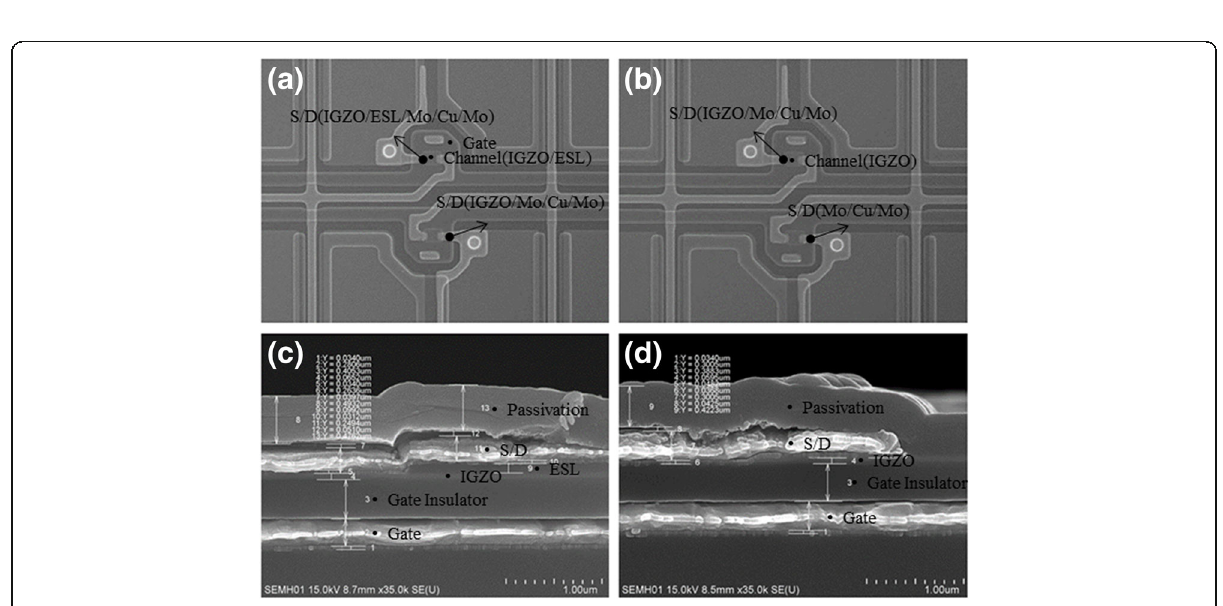
Fig. 3 (Color online) SEM images of a-IGZO TFT ( a , b top view; c , d side view) with CL-ES structure ( a , c ) and BCE structure ( b , d